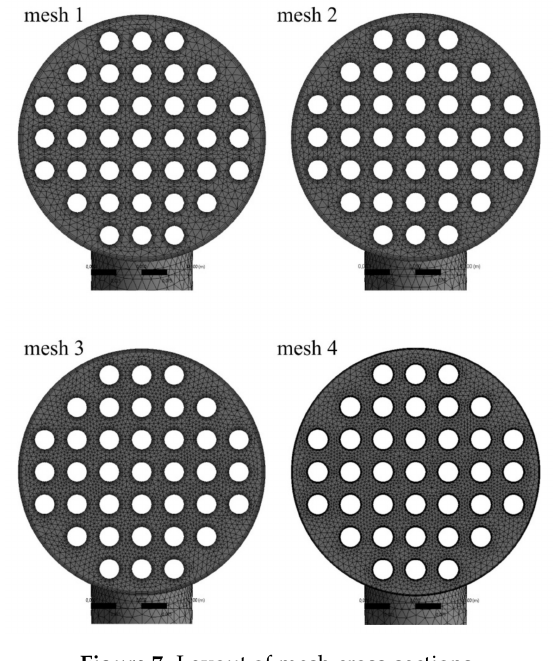
Figure 7. Layout of mesh cross-sections.